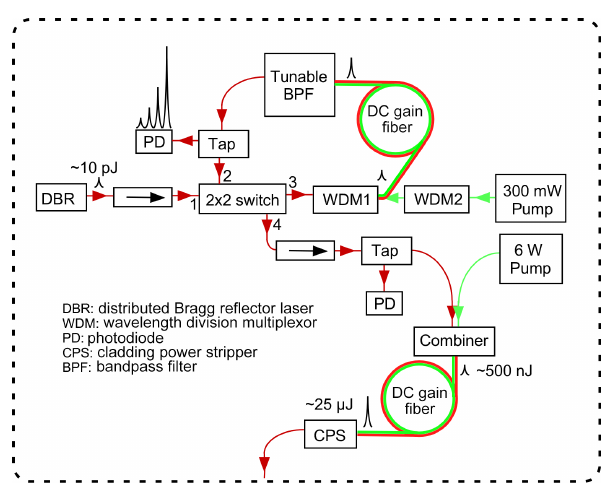
Figure 3. Schematic of the fiber-amplified diode laser system at 1084.5nm. See text in Sect. 2.2 for detailed